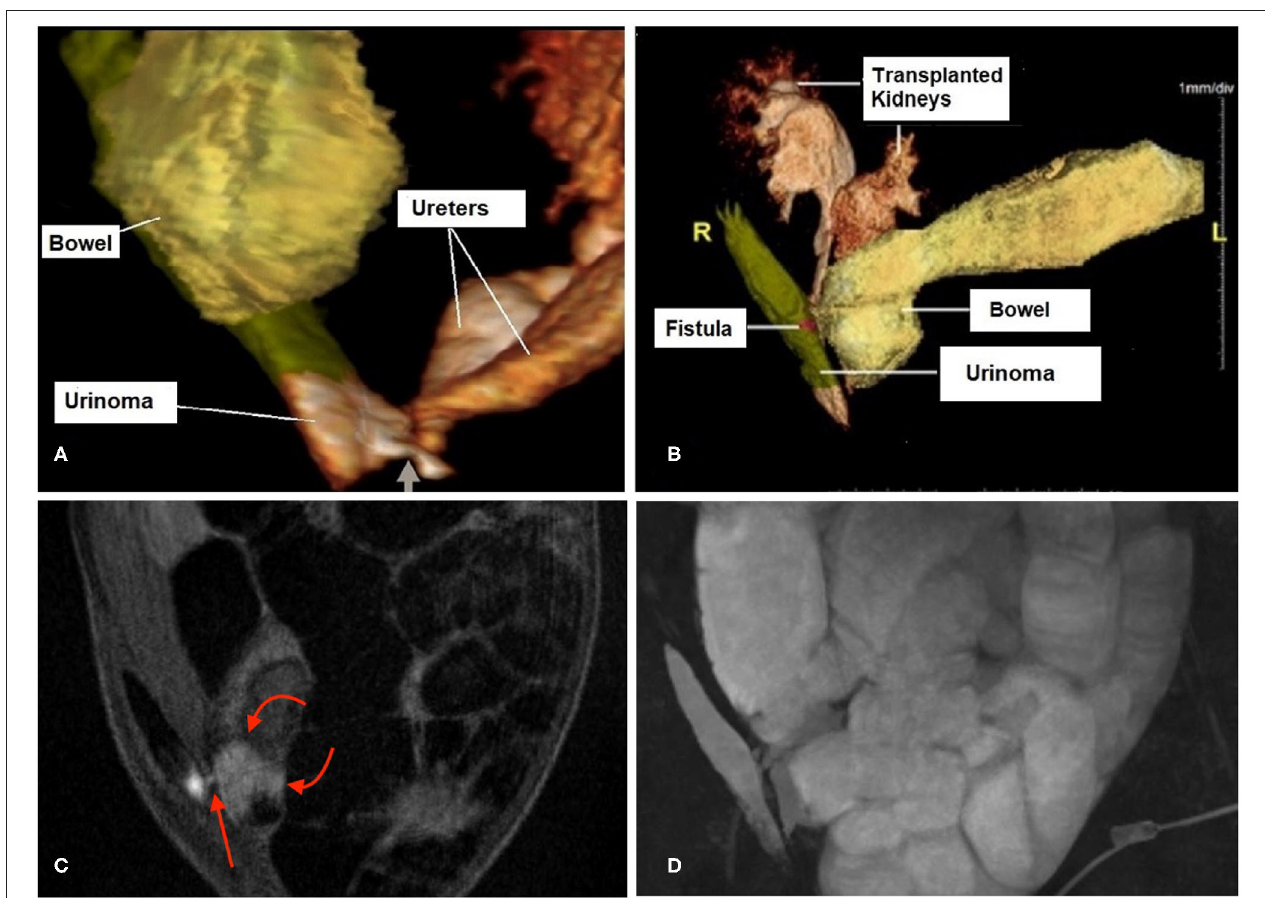
FIGURE 2 | 3D magnetic resonance urogram (MRU) images show a urinoma to small bowel fistula. (A) Shows the 2 ureters of the pediatric-en-bloc kidney transplant draining into a 8.6 × 3.9 × 1.1cm fluid collection (labeled “Urinoma”) located in the right lateral abdominal wall. The connection between the distal ureters at the base of the collection is shown (short arrow). (B) Shows the urinoma has developed a fistulous tract (magenta highlight labeled “Fistula”) which drains into the proximal small bowel limb where the excreted contrast is seen progressively filling the bowel. (C) This sequence shows a cross-section of the tiny fistula (red arrow). Note that the bright urine in the urinoma is seen starting to mix with the fluid in the adjacent bowel (curved arrows), in contrast to the otherwise dark bowel contents throughout the rest of the image. (D) This 3D maximum intensity projection shows the location of the urinoma along the right abdominal wall which is filling the markedly dilated bowel with fluid which is